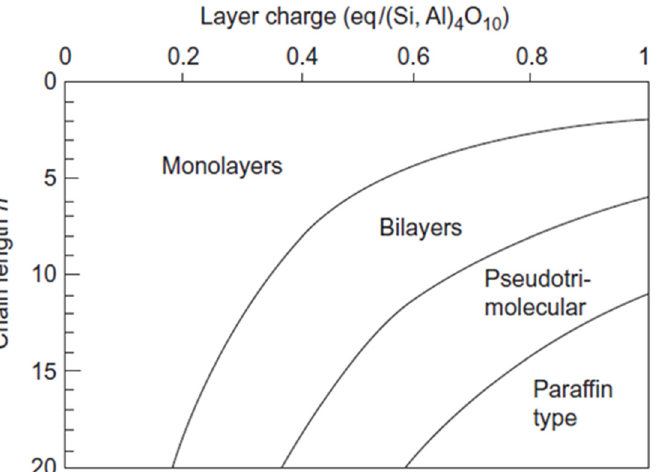
Figure 3. Influence of the layer charge and length of the alkyl chain on the position of alkylammonium ions in the interlayer space